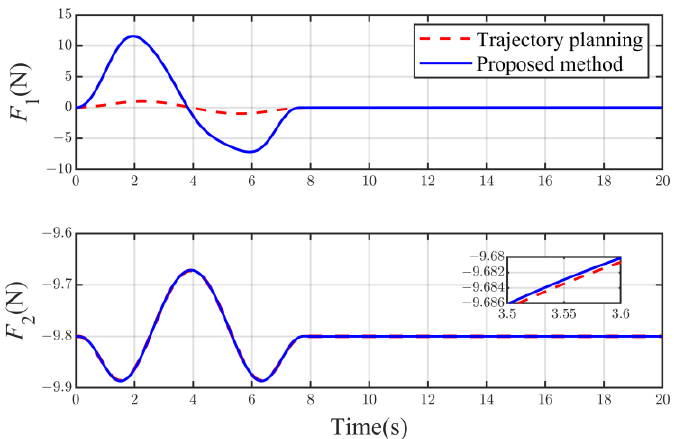
Figure 5. Control input without external disturbances.